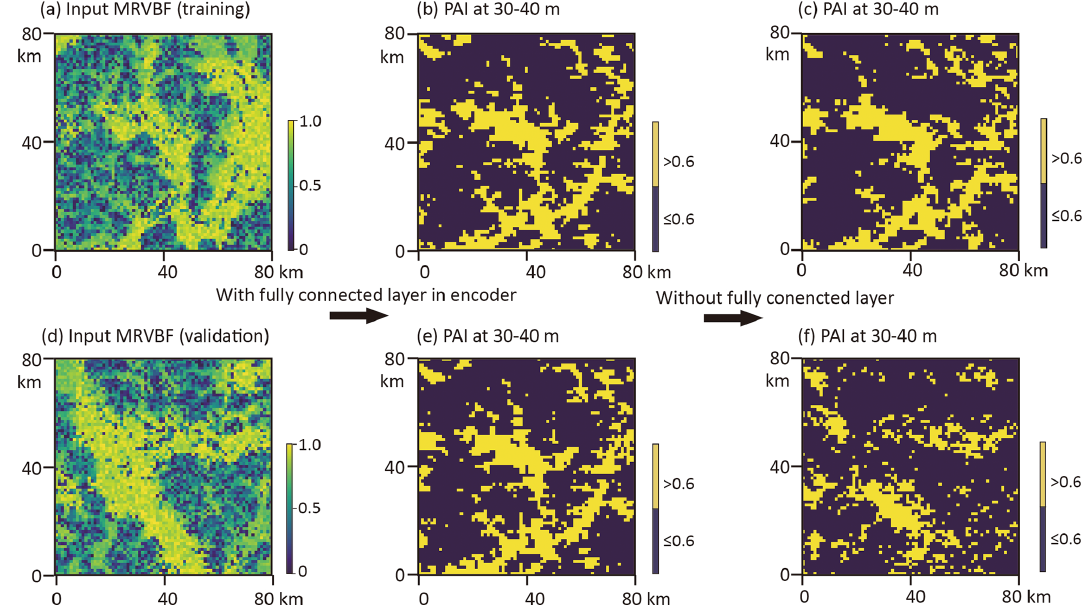
Figure 7. Input MrVBF in (a) training area and (d) validation area and (b, e) the generated PAI at a depth of 30–40m with fully connected operation in the encoder and (c, f) without fully connected